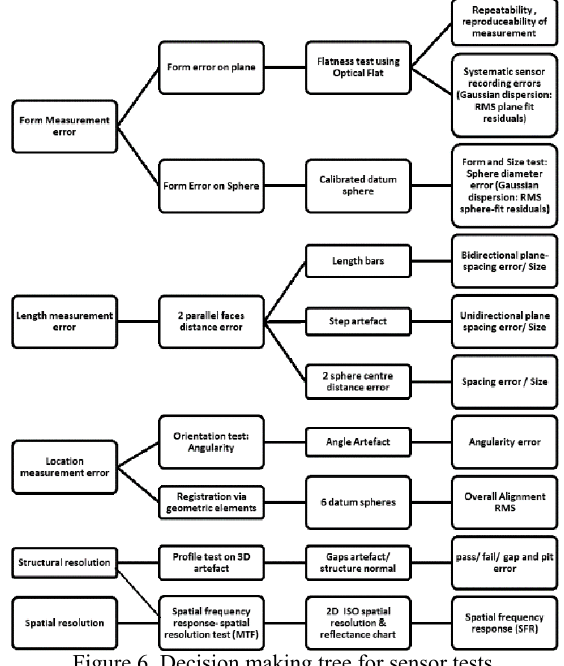
Figure 6. Decision making tree for sensor